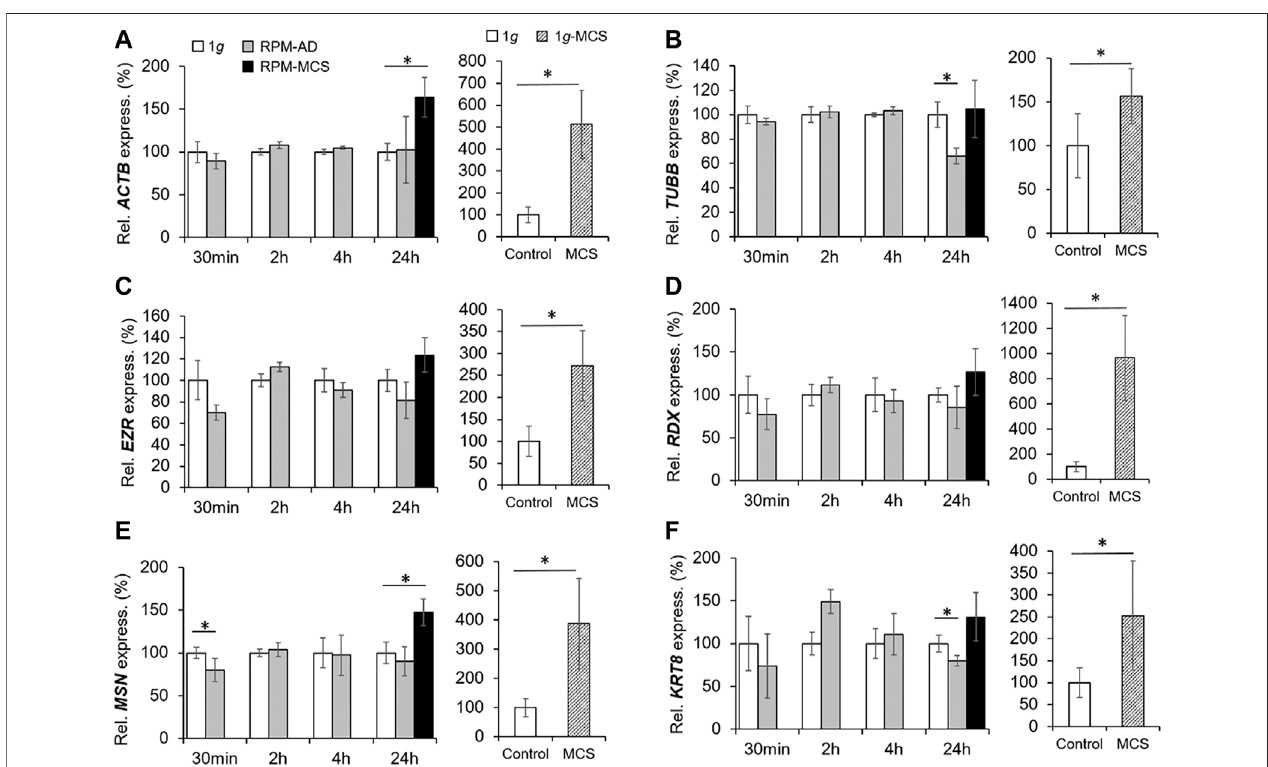
FIGURE 3 | Gene expression of (A) ACTB, (B) TUBB, (C) EZR, (D) RDX, (E) MSN and (F) KRT8 of PC-3 cells exposed to the RPM for 30 min, 2, 4 and 24 h and 1 g -MCS after 24 h. n = 5; * p < 0.05 vs. 1 g .